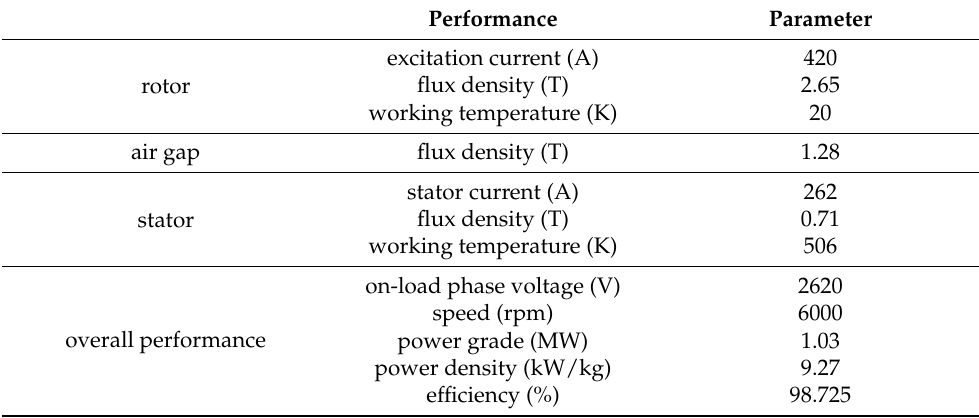
Table 5. Performances of the